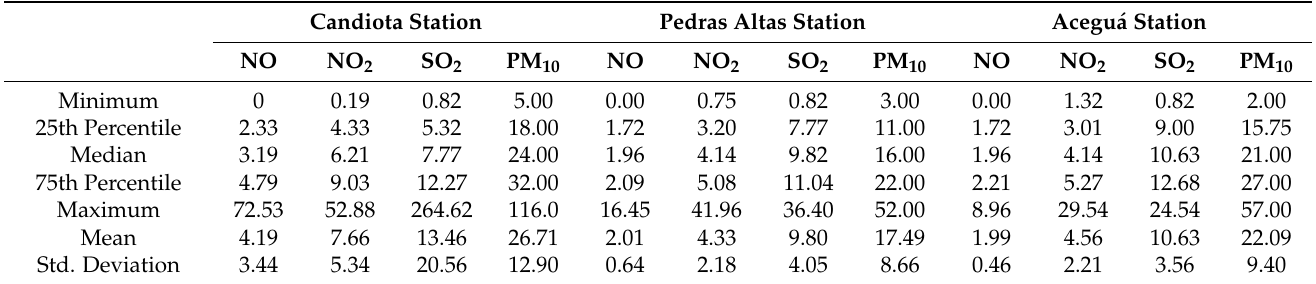
Table 1. Information on the concentrations ( µ g/m 3 ) of air pollutants in the study region.